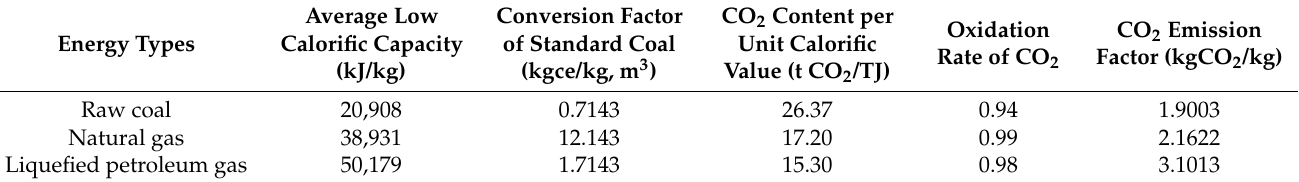
Table 4. Conversion factors of standard coal and CO 2 emission factors.